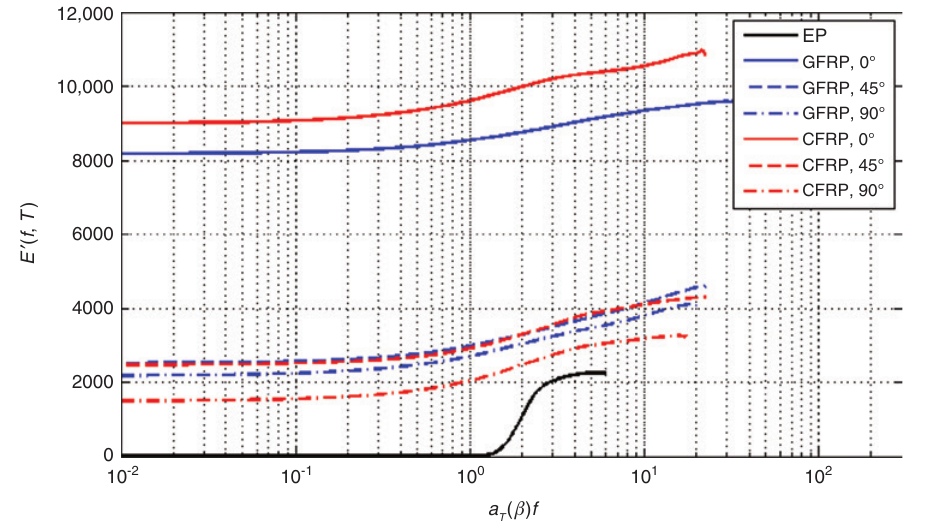
Figure 8: Master curves of the storage modulus for various materials and fibre